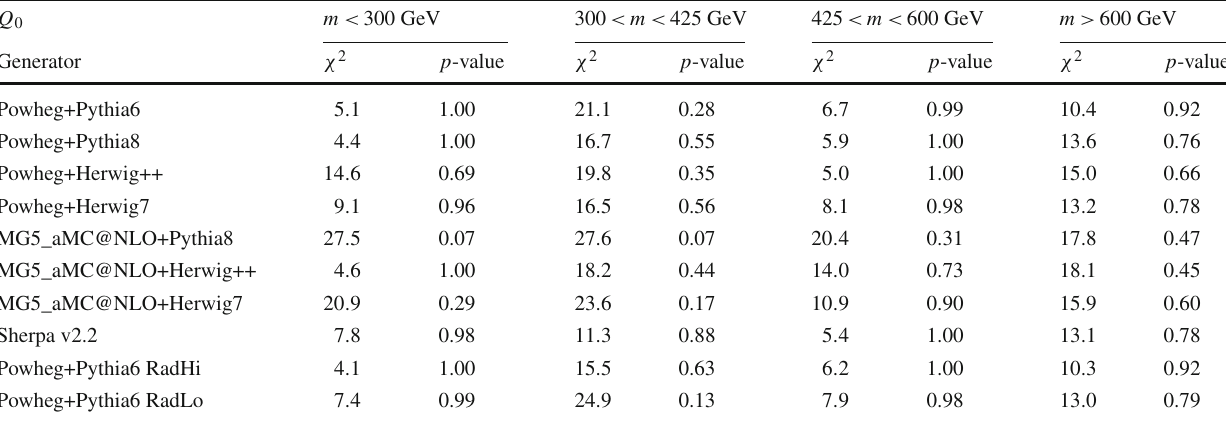
Table 14 Measurements of χ 2 comparing the measured gap fraction distributions with predictions from various t ¯ t generator configurations, for the four invariant mass m e μ bb regions as a function of Q 0 . The χ 2 and p -values correspond to 18 degrees of